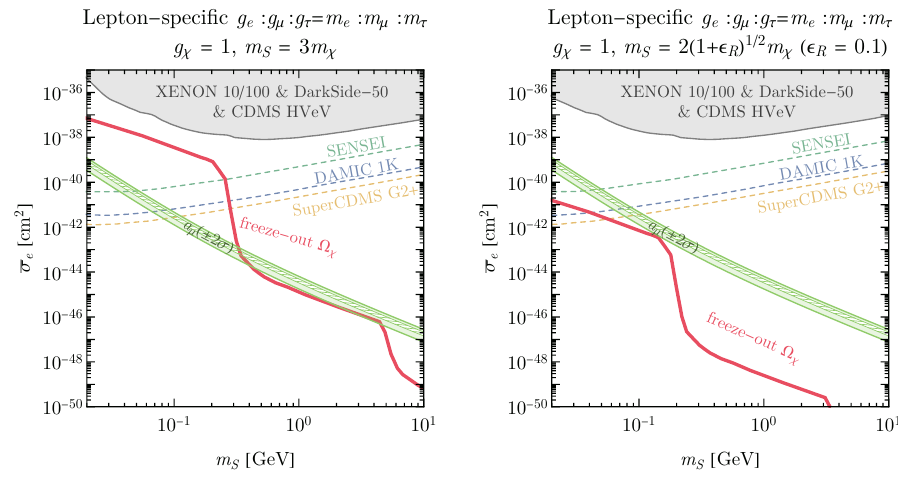
Figure 7. The predicted dark matter-electron scattering cross-section, (cid:27) e , for a leptophilic scalar p mediator with g (cid:31) = 1, and m (cid:31) = m S = 3 (left) and m S = (2 1 + (cid:15) R ) with (cid:15) R = 0 : 1 (right). Also shown are constraints and projections from present and future direct detection experiments. Regions above the experimental sensitivity curves are expected to be probed. Values of (cid:27) e corresponding to the couplings g e required to saturate the relic abundance in each case are given by the red contours. The current (future) a (cid:22) -favored band is also indicated by the shaded (hashed) green regions.